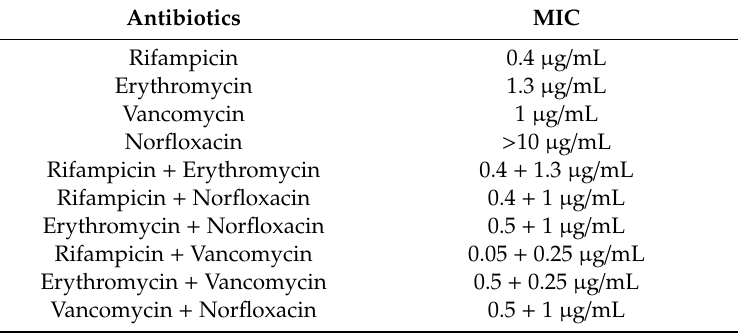
Table 1. MICs of different antibacterial compounds and their combinations against R. equi 103S + . The data are resulting from three independent experiments with two technical replicates per assay.